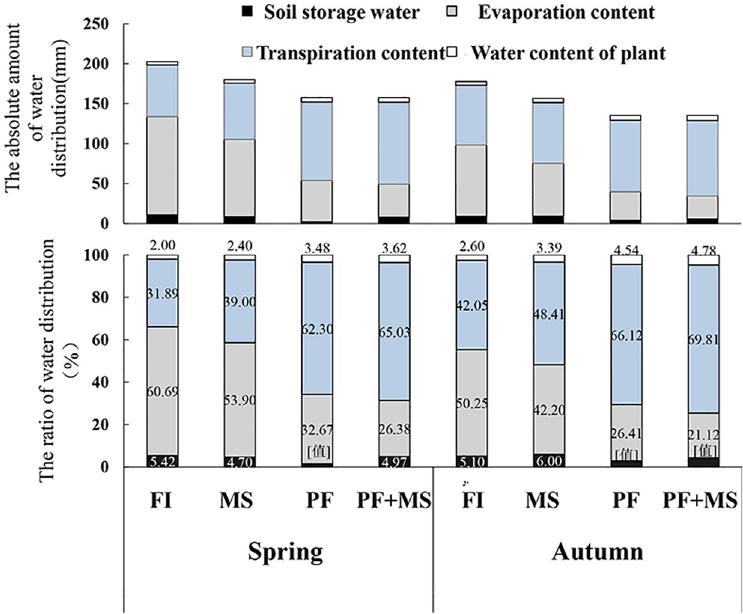
Fig 5. Effects of water irrigation systems on absolute amount of water distribution and water distribution through the